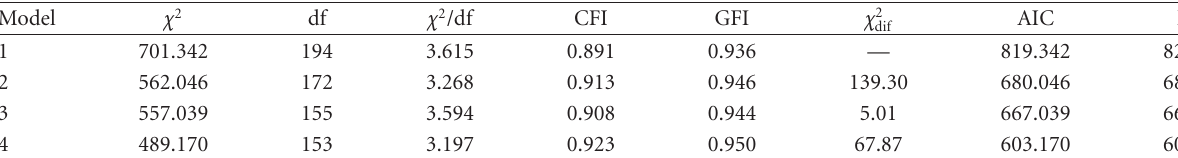
Table 4: Goodness-of-fit statistics for confirmatory factor analysis models of P3A.